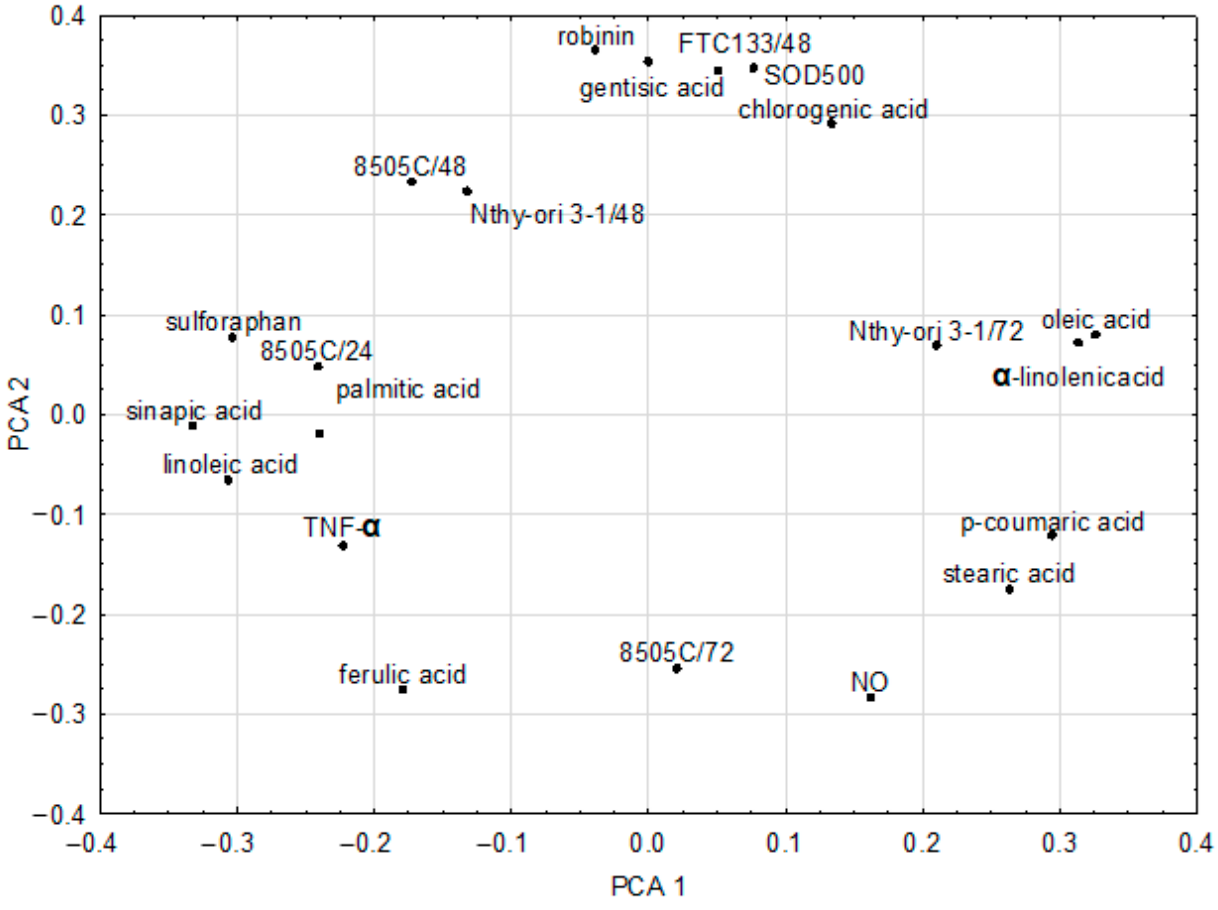
Figure 4. Loadings for the first two principal components of the PCA model (FTC133/48—48 h of incubation; 8505C/24/48—24 h or 48 h of incubation; Nthy-ori 3-1/48/72—48 h or 72 h of incubation; SOD500—SOD activity 500 μ g/mL).